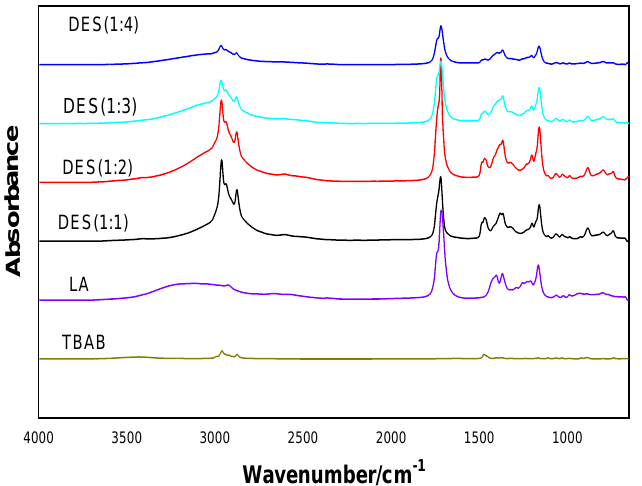
Figure 4. FT-IR spectra of LA, TBAB, and DESs formed by LA and TBAB with a 1:1−1:4 mol ratio.